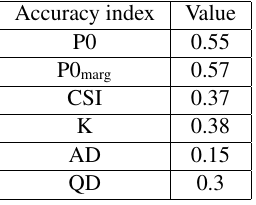
Table 4. Global accuracy indexes for Europe